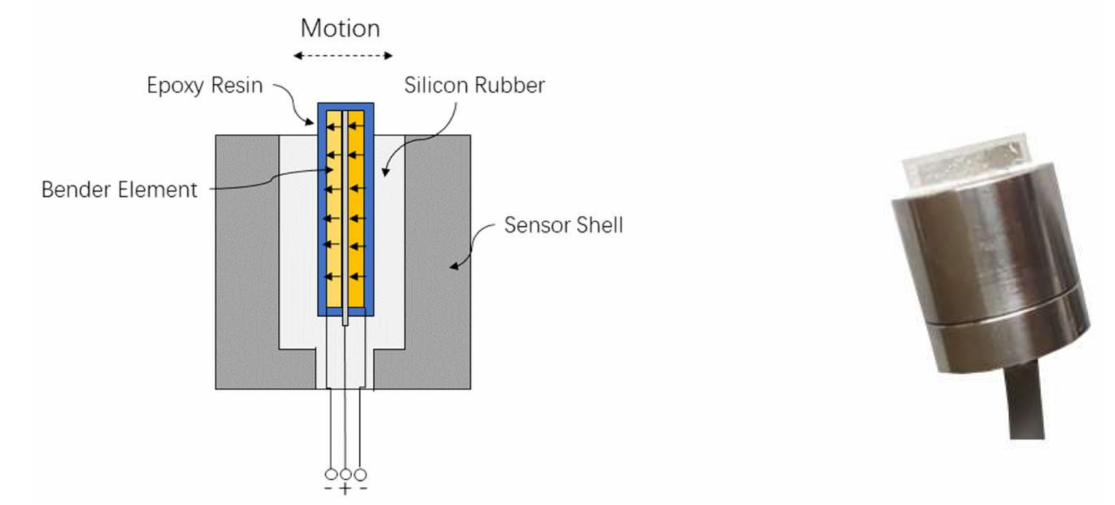
Figure 2. Bender element sensors and its working